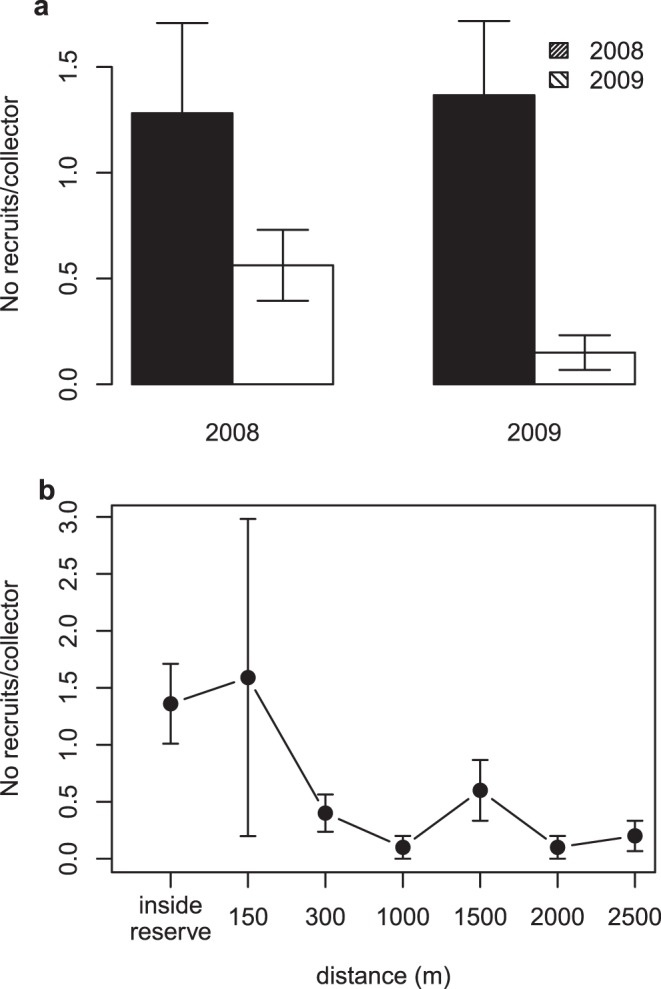
Postlarval recruit abundance within and outside marine reserves.(a) Postlarval recruit abundance (averaged across the recruitment season,
±1SE) within the Punta Prieta reserve and nearby fished area in 2008
and 2009, before and after the mass mortality event of spring 2009; (b)
postlarval recruit abundance (averaged across the recruitment season) within
the reserve and at varying distances from the reserve edge.